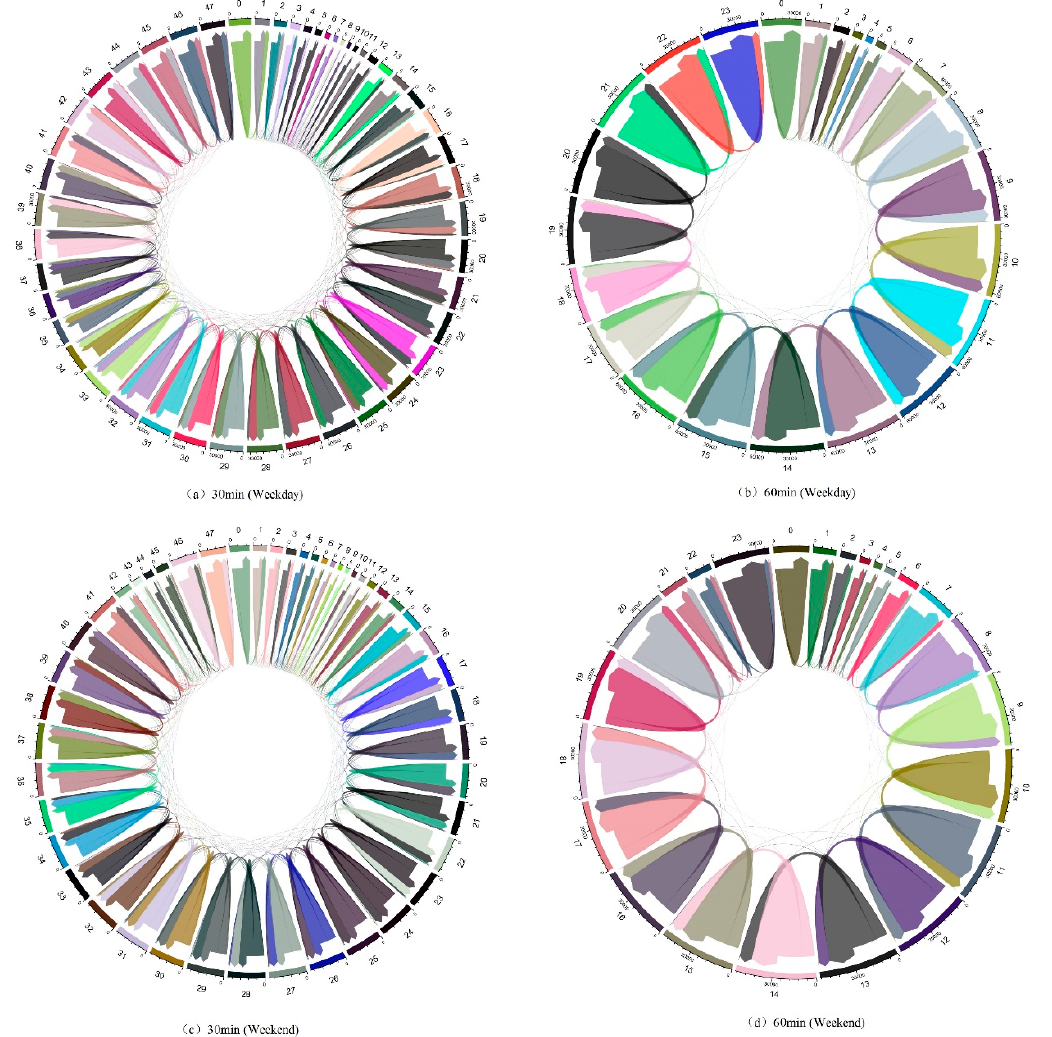
Figure 12. Multitime scale visualizations for taxi OD data in Beijing based on the chord diagram plot.